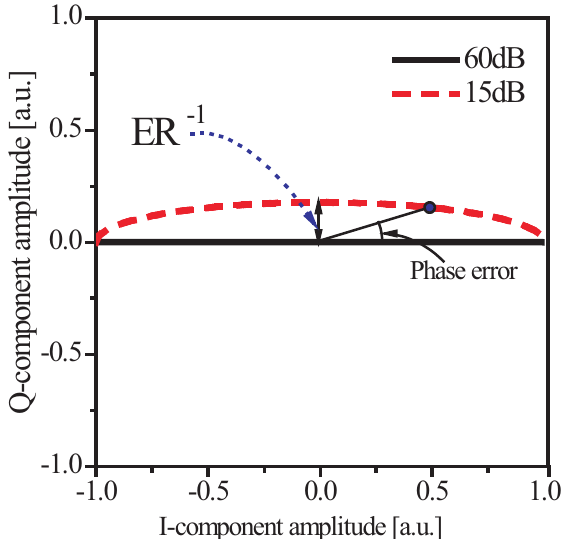
Figure 9. IQ diagrams of optical outputs from MZMs, where ERs were 15 dB and 60 dB [12].